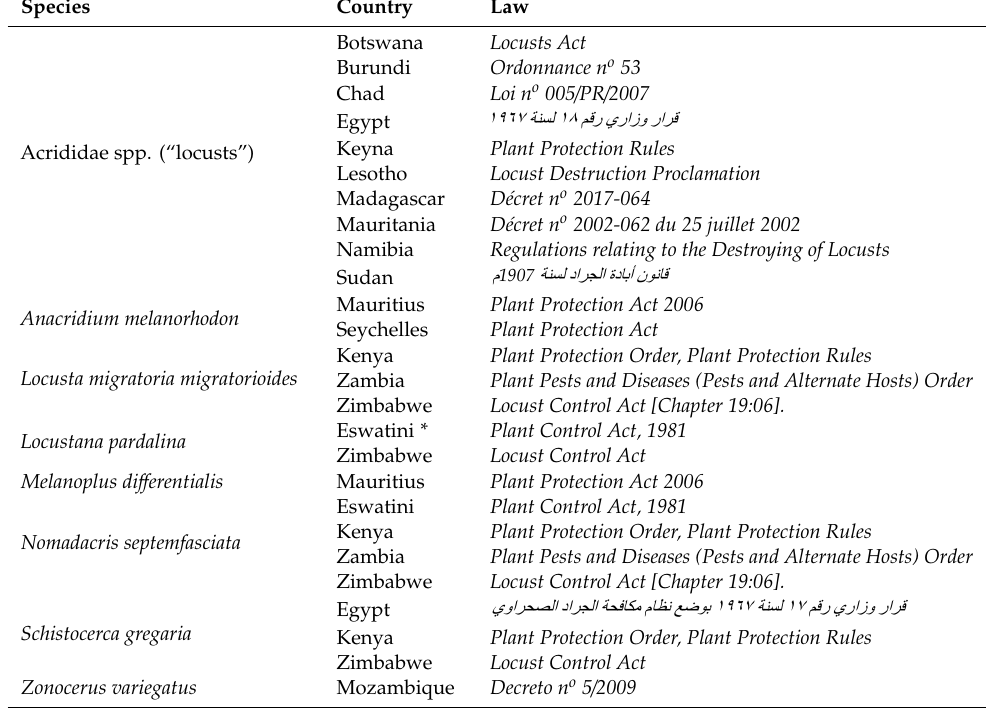
Swarming locusts have been a threat for the agriculture for millennia. Along with the CLCPRO and CRC initiatives, many countries have adopted national regulations. However, only some do actually include concrete measures. In other countries, the fight against locusts is documented legally by the will to build up corresponding organizations and initiatives, i.e., the national anti-locust agency (ANLA) in the Chadian Loi n o 005 /PR/2007 , IFVM in Madagascar ( Décret n o 2017-064 du 31 du janvier 2017), the CNLP in Mali ( Loi n o 06-065 du 29 décembre 2006 and subsequent texts), the PLUCP in Niger ( Arrêté n o 13/MDA/DPV ), and the campaigns in Morocco ( Loi n o 57-02 ) and Tunisia ( Décret n o 88-1751). In those countries, locust may be combatted efficiently, but this is not reflected in the law. Table 7. Pest insect legislation pertaining edible insect species (as presented in [11]): locusts (Orthoptera; all species are Acrididae, except for Zonocerus variegatus (Zygomorphidae)). Species Country Law